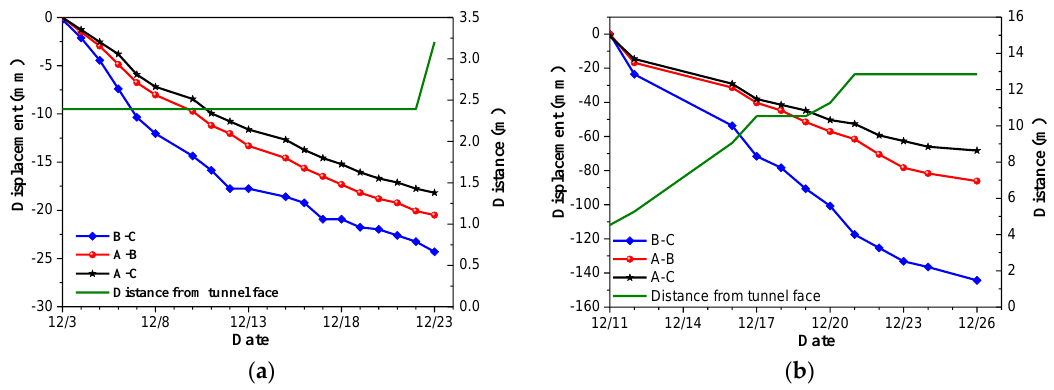
Figure 14. ( a ) Monitoring results of clearance convergence deformation in Section 5; ( b ) monitoring results of clearance convergence deformation in Section 2.